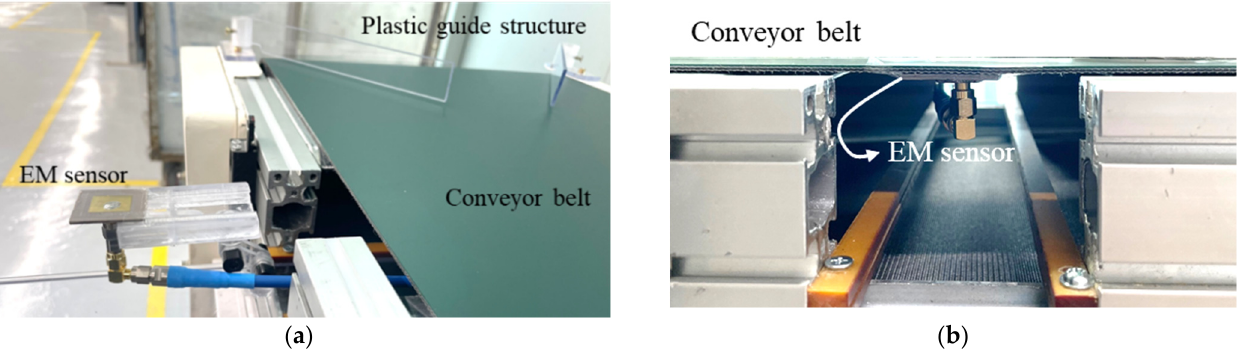
Figure 9. Photograph of experiment setup including EM sensor. ( a ) Before mounting below conveyor belt. ( b ) After mounting below conveyor belt.